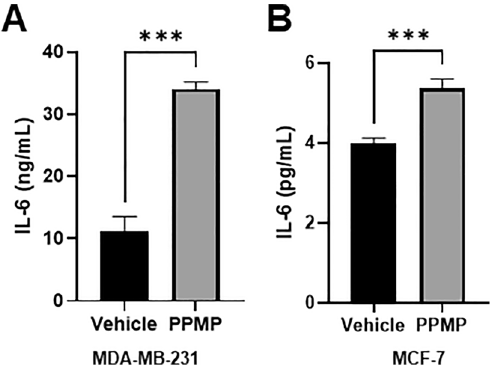
Figure 6. Effect of PPMP on pro-inflammatory cytokines in breast cancer cells. ( A ) and ( B ) IL-6 secretion was evaluated by an ELISA in MDA-MB-231 and MCF-7 breast cancer cells (unpaired two-tailed t test, *** p < 0.001, n = 3 for the MDA-MB-231 cells; n = 6 for the MCF-7